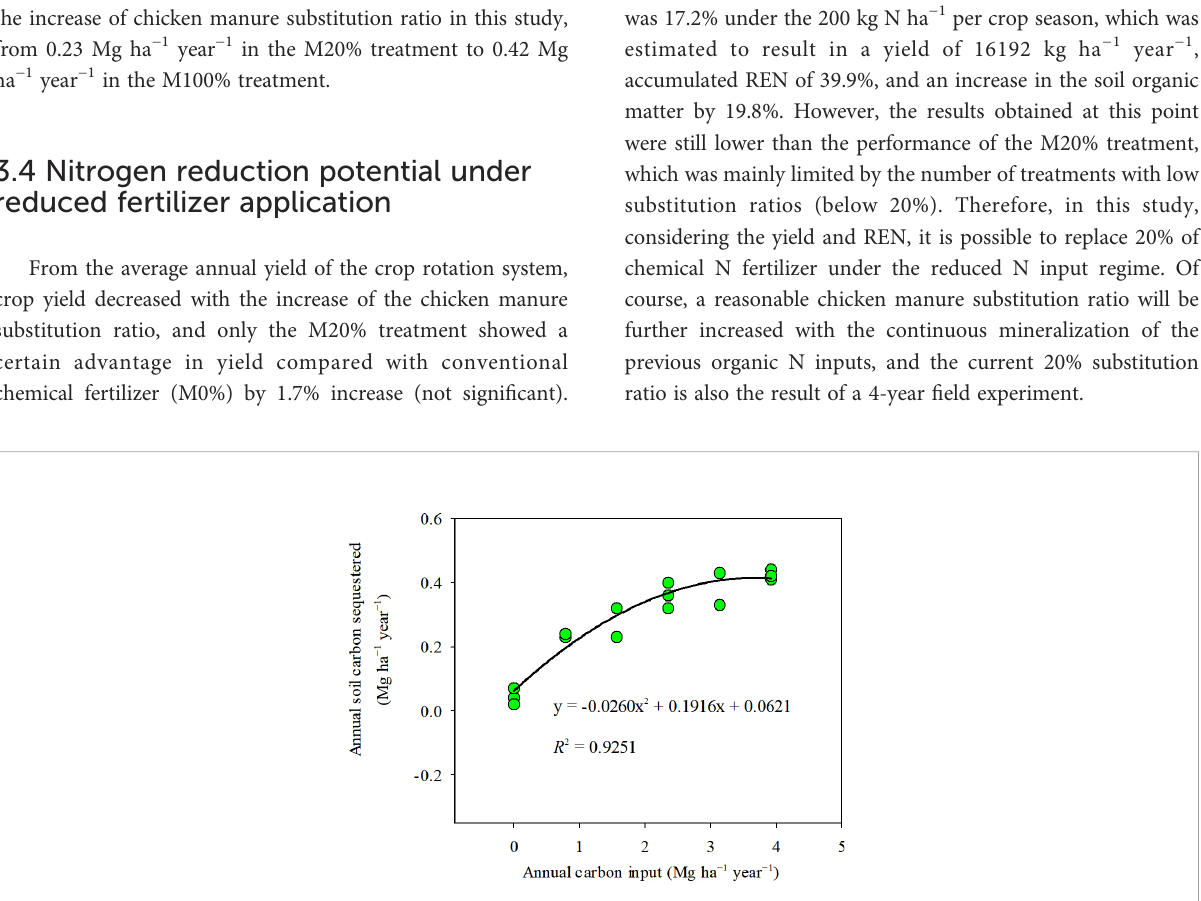
FIGURE 3 Relationship between annual soil organic carbon sequestration rate and annual carbon input in the wheat-maize rotation